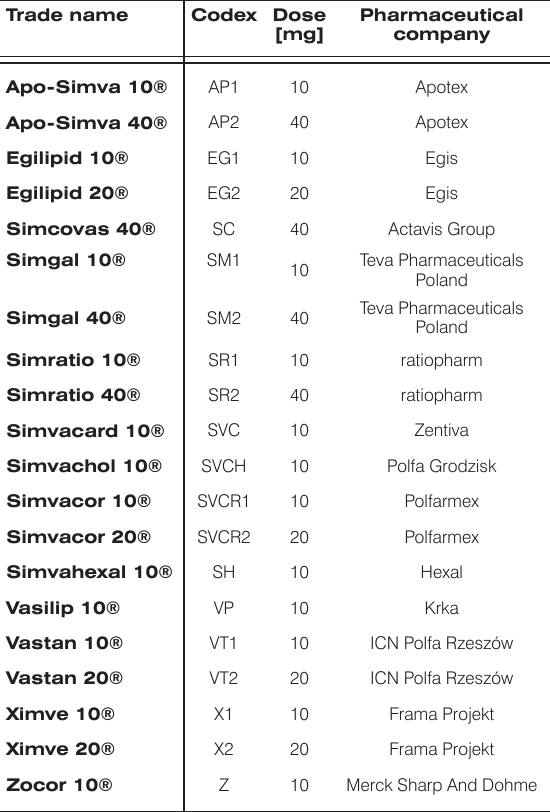
Table 1. List of the studied commercial simvastatin